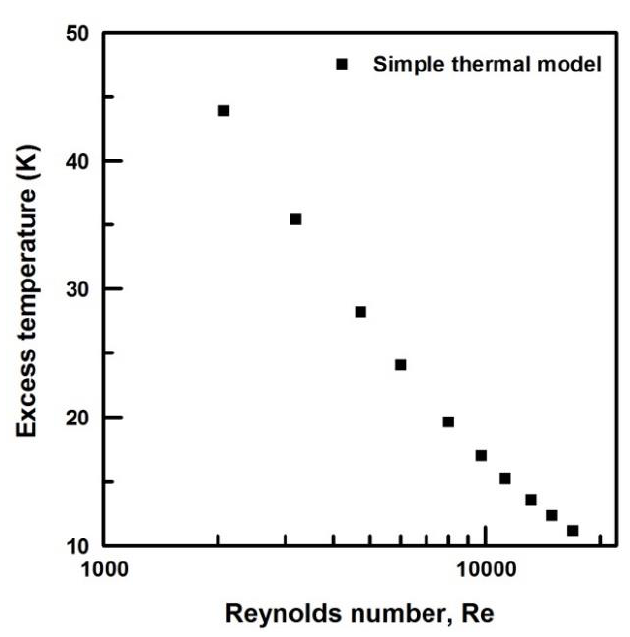
Figure 7. Excess temperature variation for simple thermal